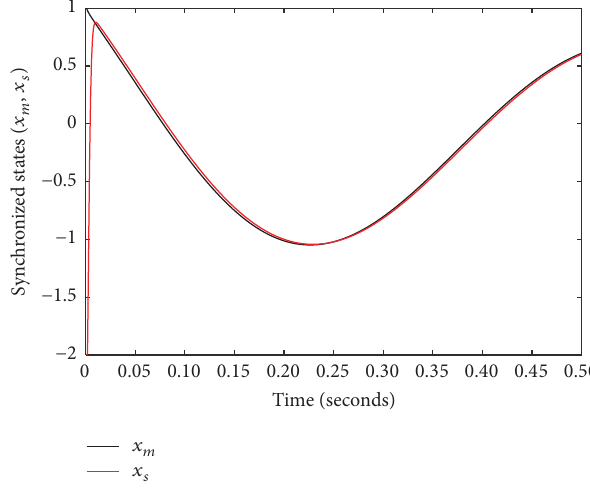
Figure 14: State synchronization ( 𝑥 𝑚 ,𝑥 𝑠 ).